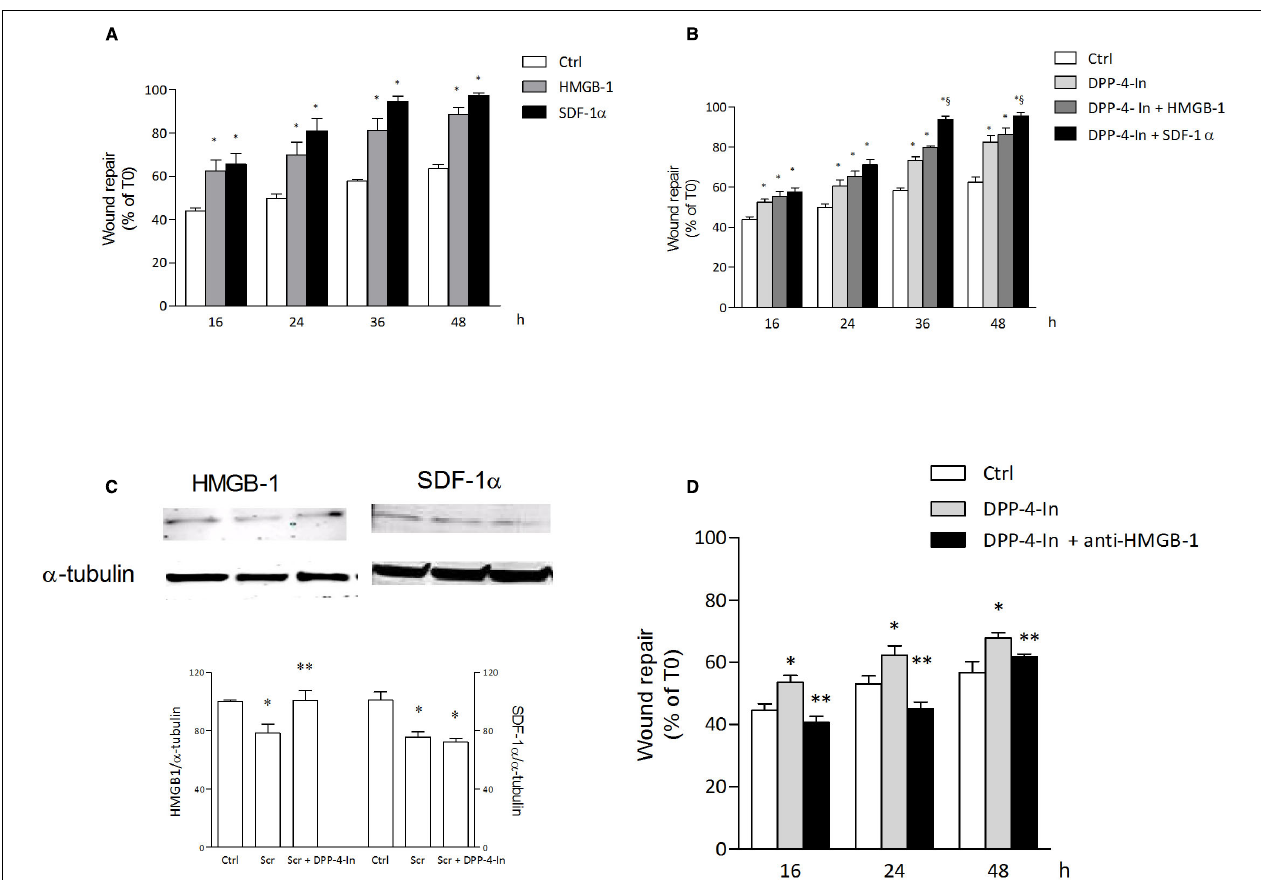
FIGURE 6 | HMGB1 is involved in the healing promoting effect of DPP4-In. HMGB1 (10 nM) and SDF-1 a (50 ng/ml) significantly increase wound repair over time in scratched NCTC 2544 keratinocytes (A) . Co-treatment with DPP4-In (10 m M) and HMGB1 (10 nM) produces a non-additive effect (B) , whereas co-addition of DPP4-In and SDF-1 a (50 ng/ml) potentiates repair induced by DPP4-In alone (B) . Western blot analysis shows that treatment with DPP4-In (10 m M, 24 h) counteracts the reduction of HMGB1, but not that of